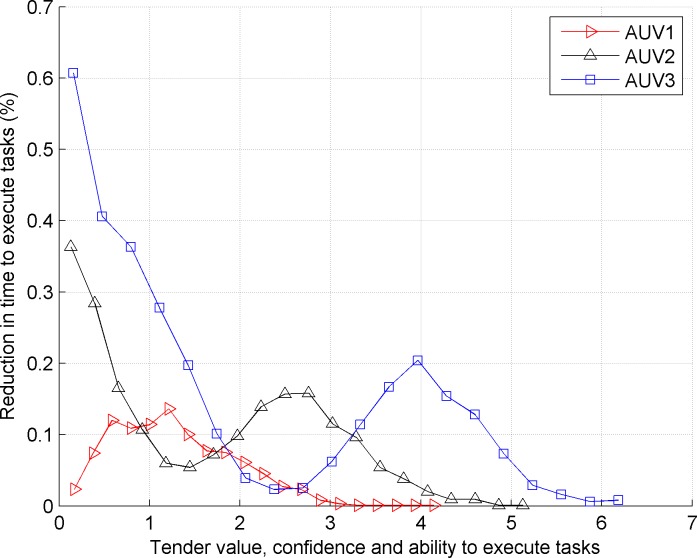
Reduced proportion (%) of AUV1, AUV2 and AUV3
AUV2
AUV3 when they executed tasks in the traditional contract net model.